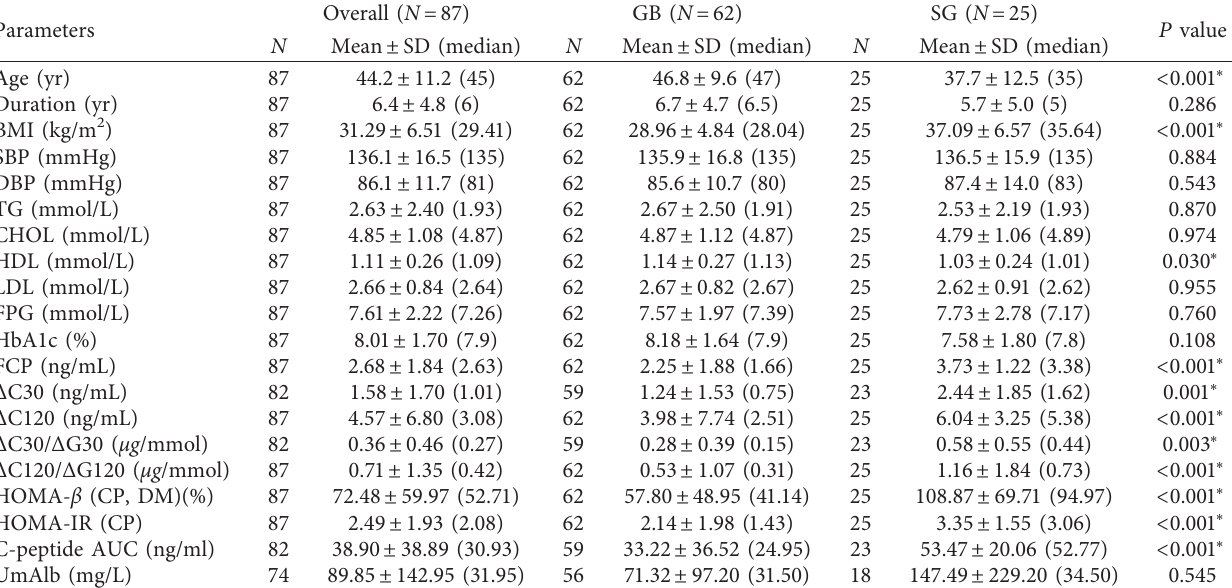
Table 1: Characteristics of the patients at baseline.